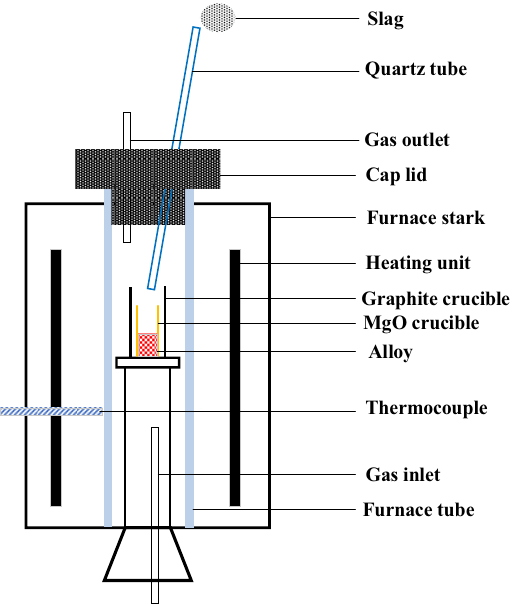
Figure 2: Schematic diagram of the equipment of the